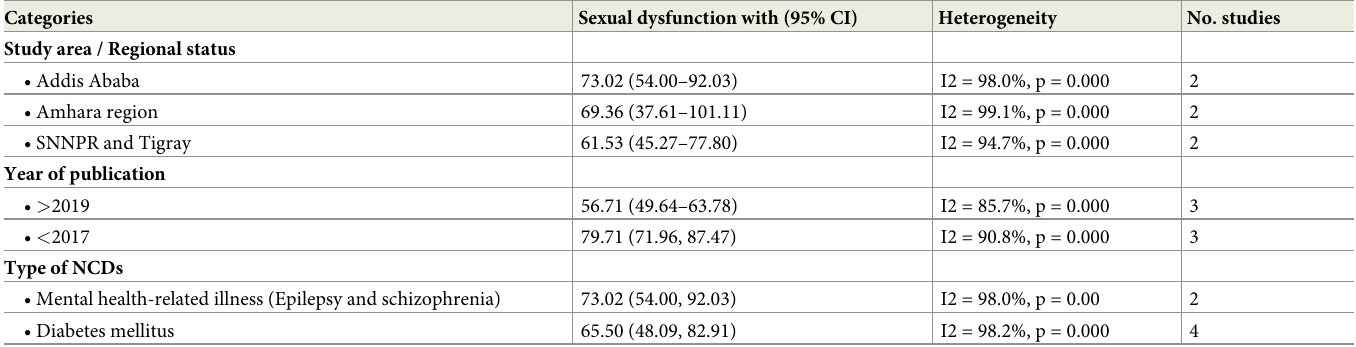
Table 2. Subgroup analysis by different category of the studies.